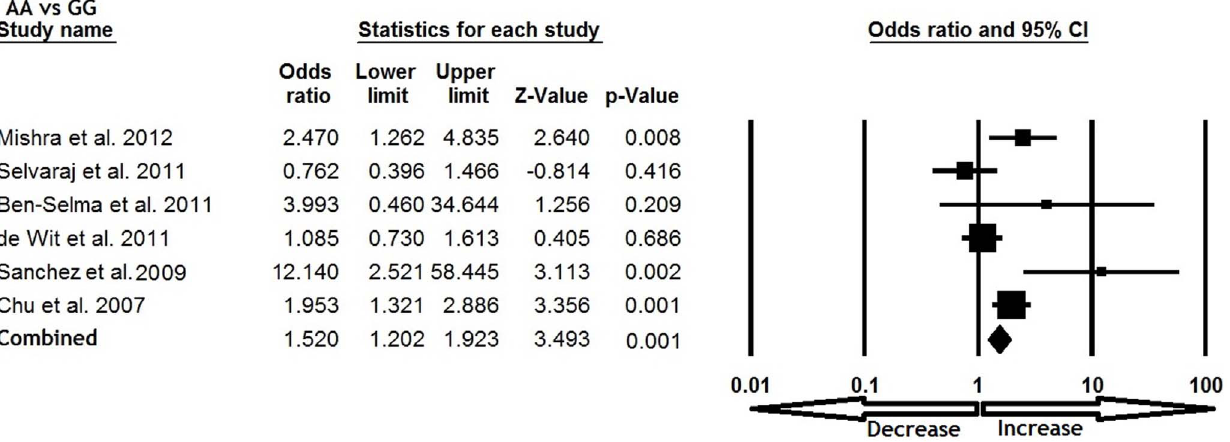
Figure 2. Forest plot and ORs with 95% CI of CCL5 -403G . A polymorphism and TB risk (AA vs. GG).